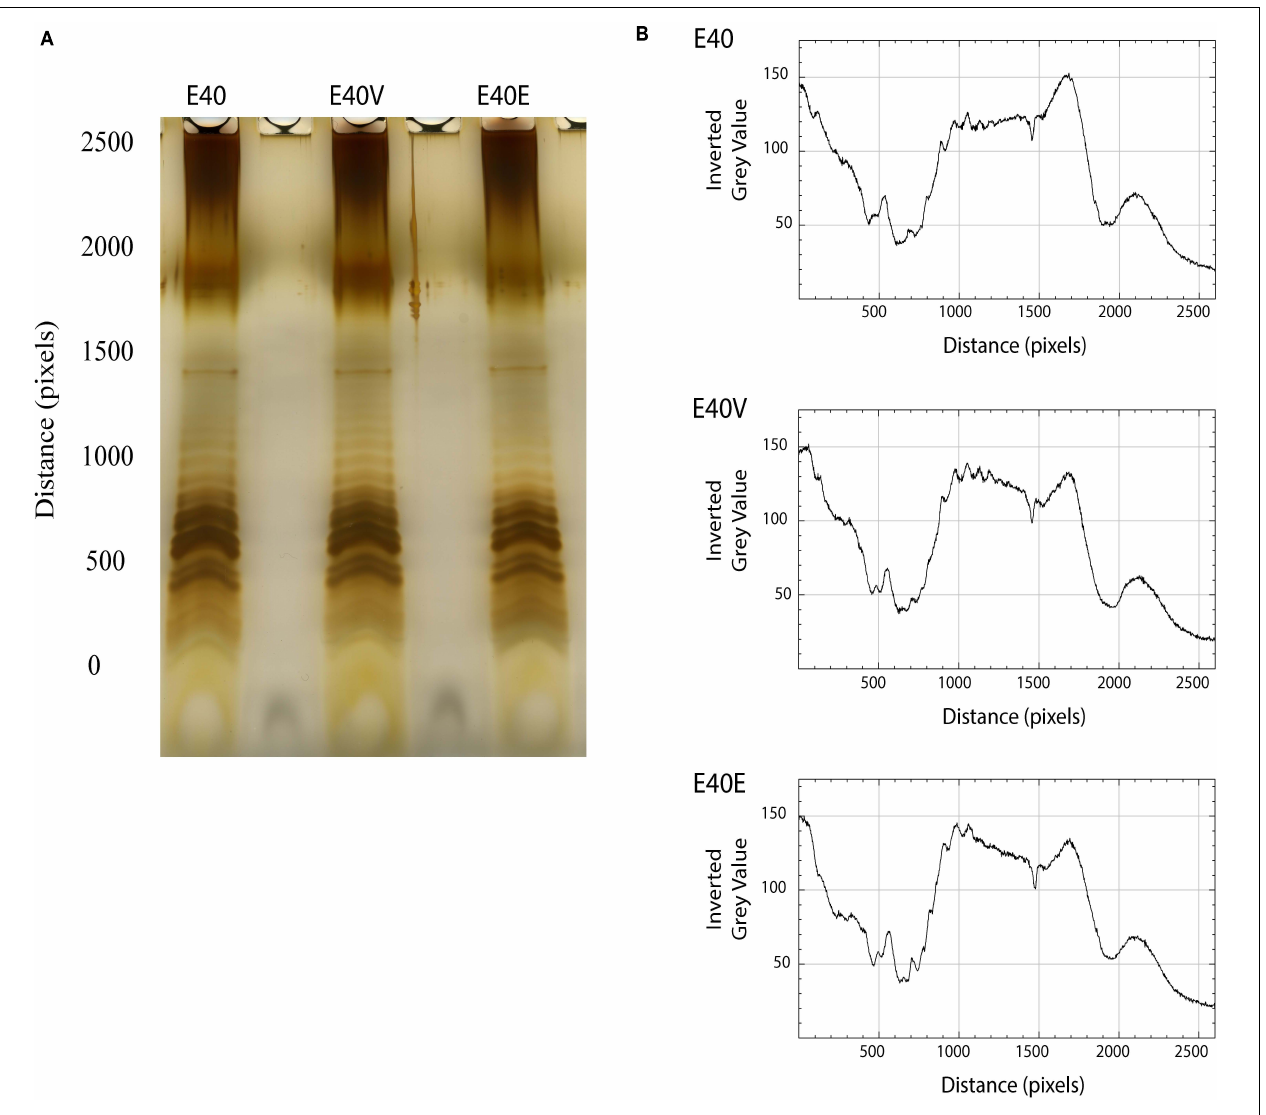
FIGURE 4 | LPS profiles and scans from E40, E40V, and E40E. (A) Cells were harvested, the LPS extracted with hot aqueous phenol, separated in a Tris-Tricine gel, and visualized by silver staining. (B) The LPS profiles were scanned using ImageJ and bands assessed by gray scale.